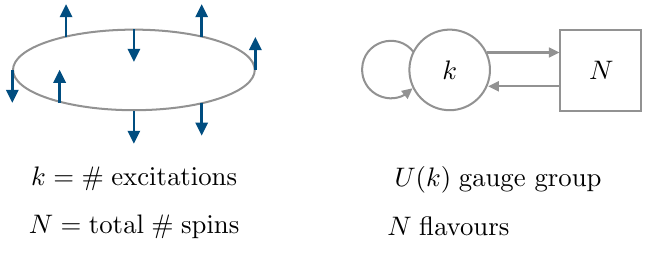
Figure 1. Basic aspects of the correspondence between spin chains and supersymmetric gauge